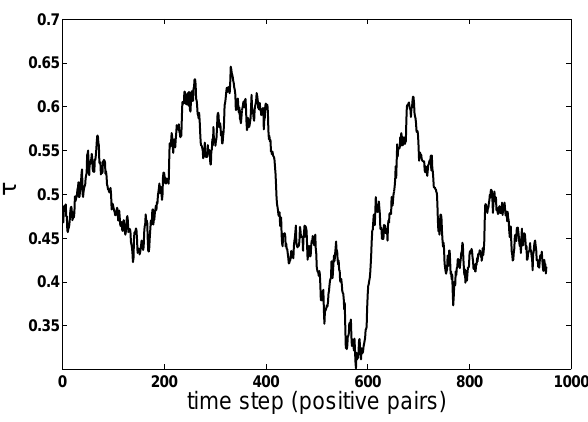
Fig. 16. Kendall’s τ of 101 consecutive positive pairs for modelled and observed precipitation at station Garmisch-Partenkirchen.